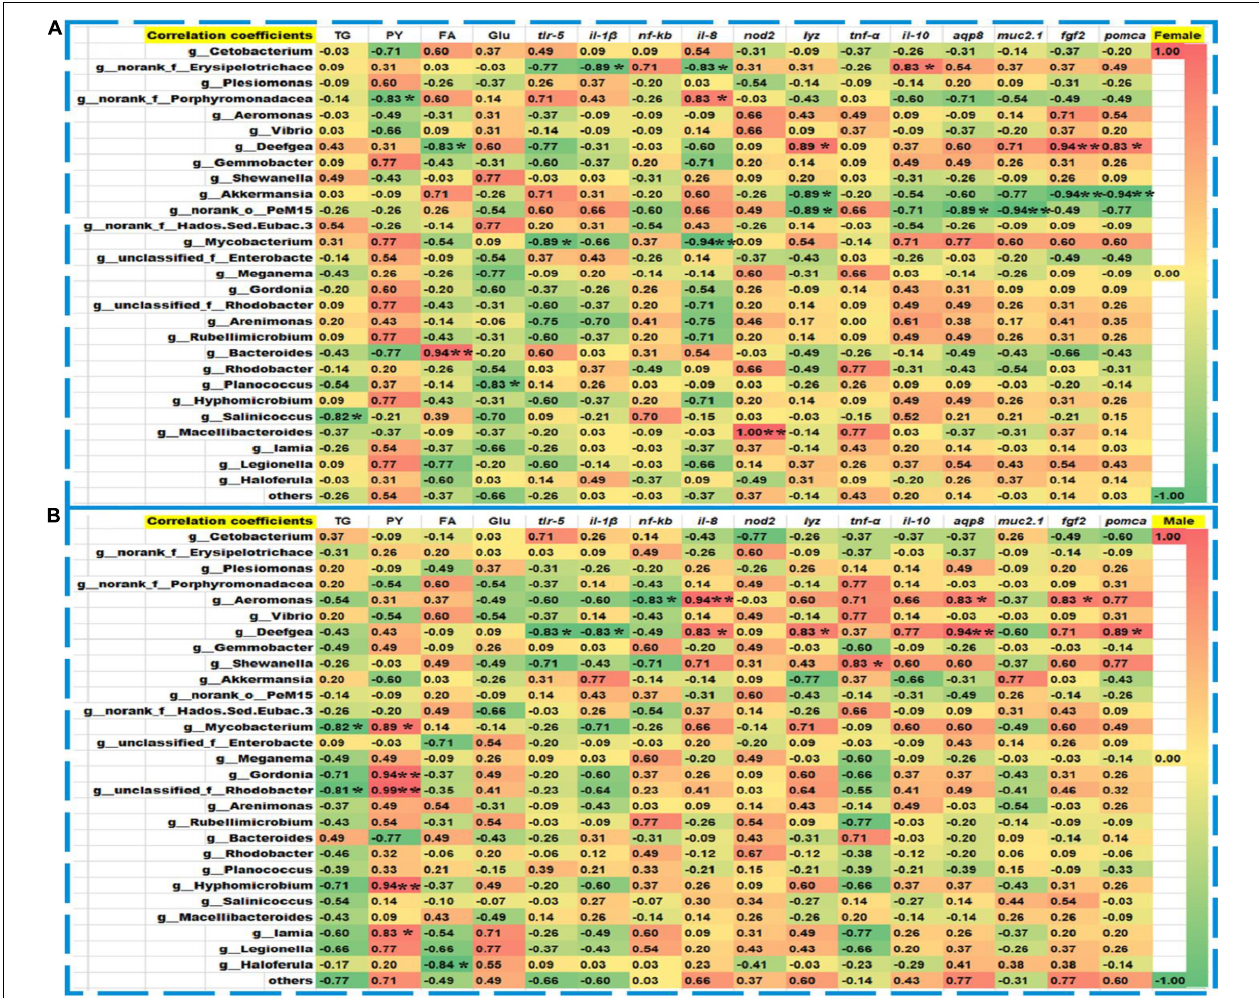
FIGURE 8 | Spearman’s correlation coefficients among the abundance of intestinal microbiota, the metabolites, and the expression of intestinal functions-related genes. In the control and DEHP exposed female (A) and male (B) zebrafish, TG, PY, FA, and tlr-5 , lyz , il-8 , tnf- α , aqp8 , fgf2, and pomca were sensitively related to the abundances of Erysipelotrichaceae , Aeromonas , Deefgea , Mycobacterium , Akkermansia , PeM15 , and Rhodobacter at the genus level. The red and blue frames indicated a positive and negative correlation, respectively. Spearman’s correlation coefficients and p values were determined by a two-tailed test and the 95% confidence interval. The scale showed the color range of different correlation coefficients among bacteria, metabolic, and gene expression, and the symbols *, ** represented the significance levels at p < 0.05 and p <